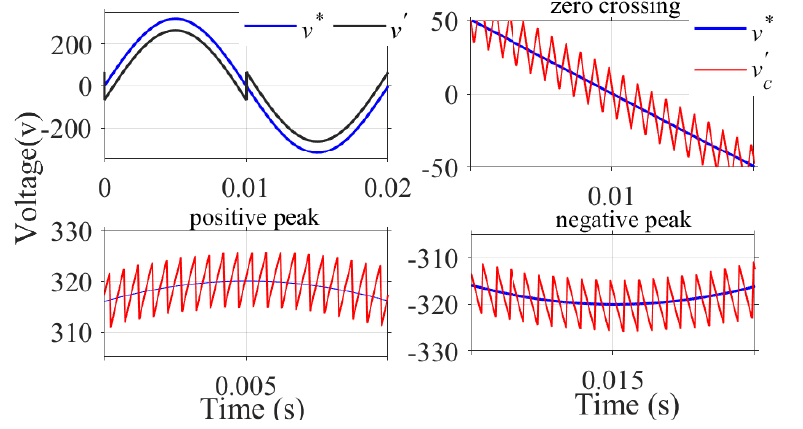
Figure 10. Waveforms of v c (cid:48) , v ∗ , and v (cid:48) with variable offset